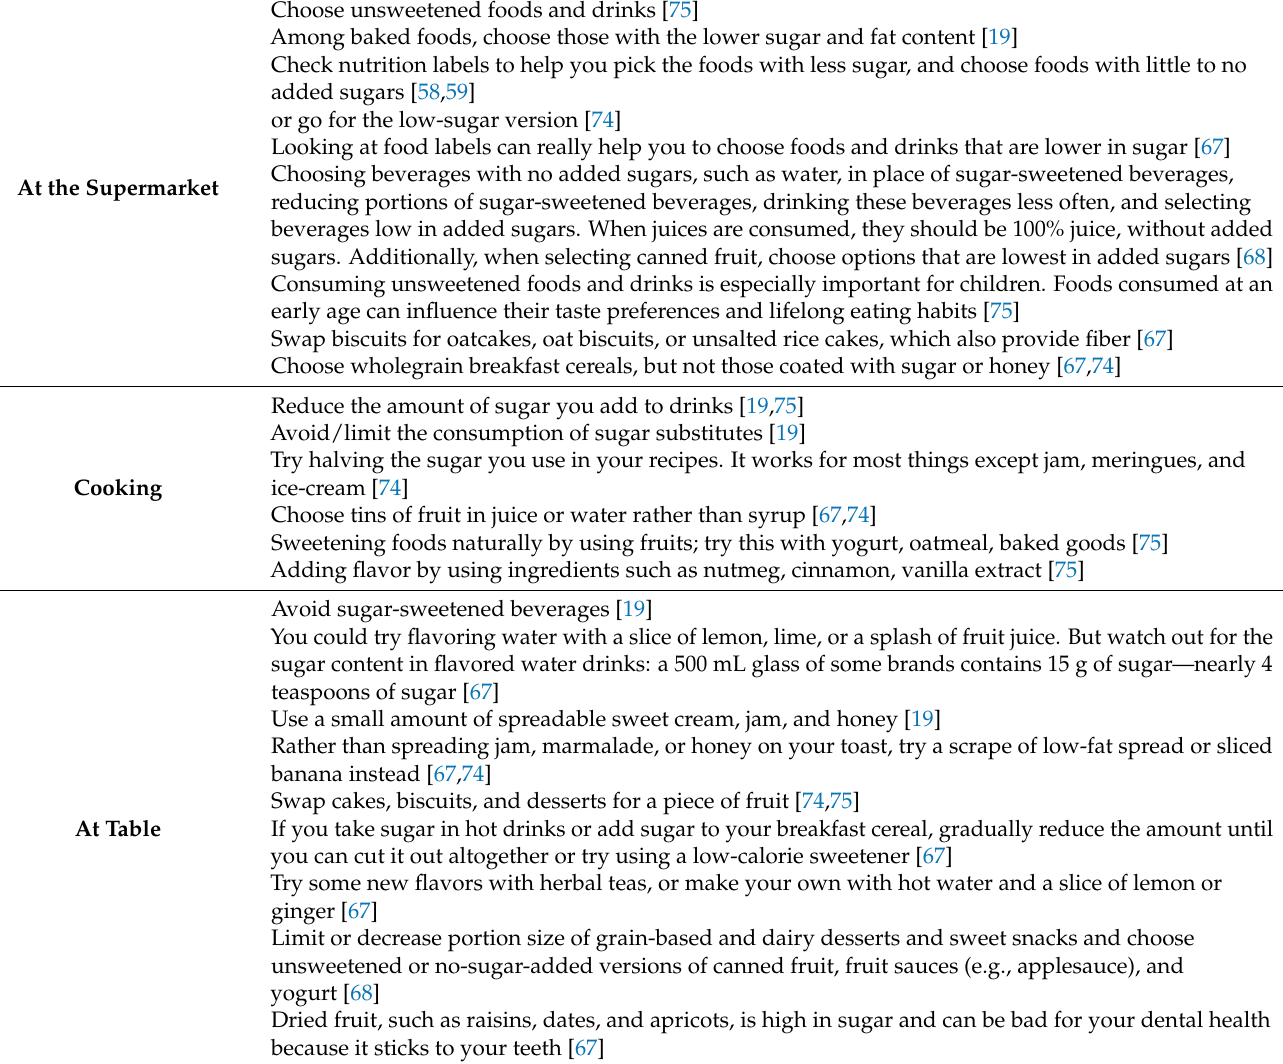
Table 3. Tips for sugar reduction according to different national